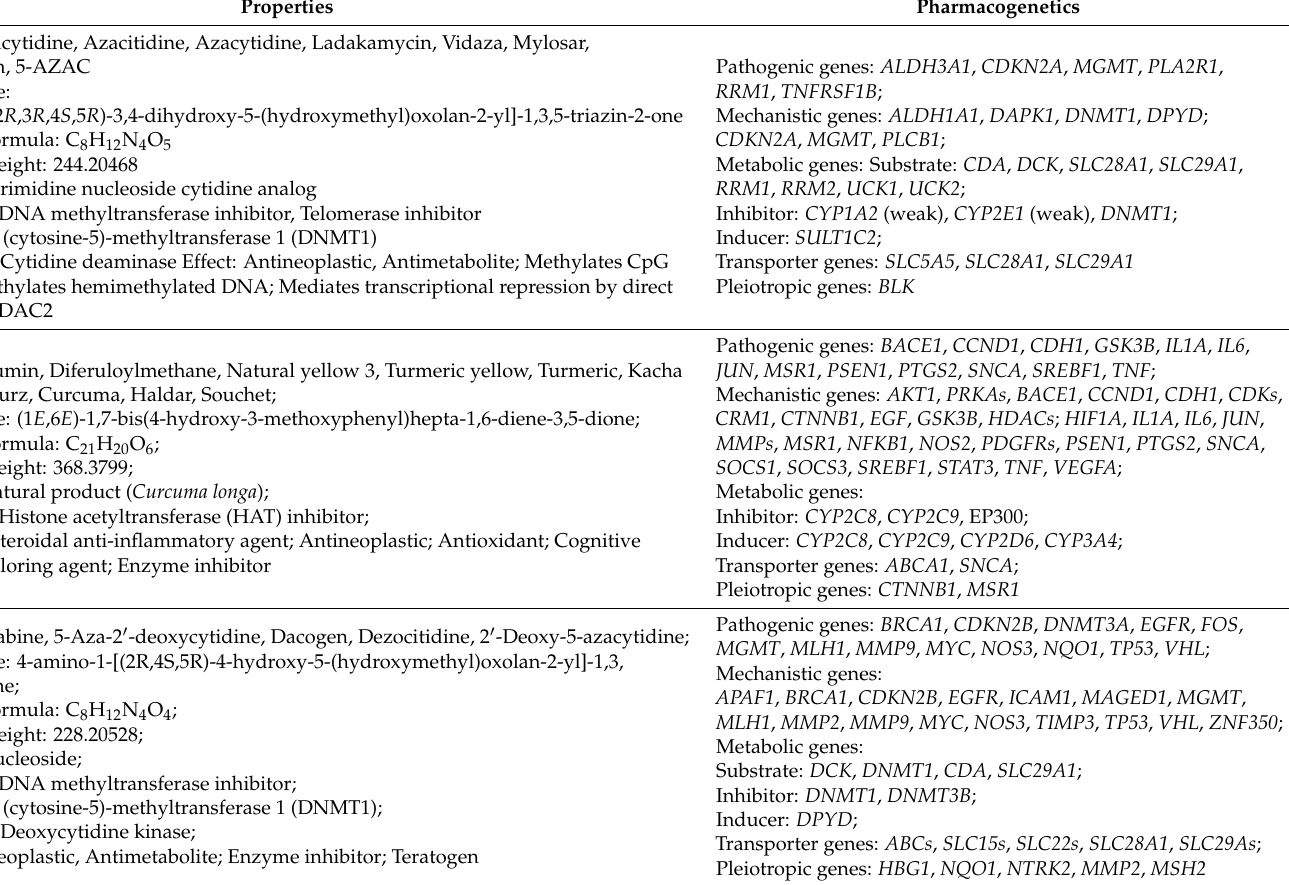
Table 2. Pharmacological profile and pharmacogenetics of selected epigenetic drugs. Drug Properties